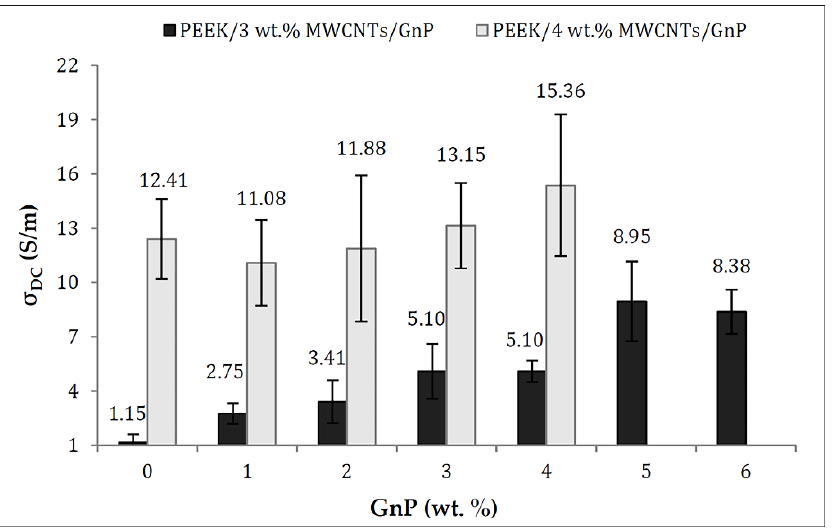
Figure 5. Direct Current (DC) volume electrical conductivity of PEEK/MWCNT/GnP nanocomposites as a function of GnP (1 to 6 wt%) content (at CNT contents of 3 and 4 wt %) [22]. Reproduced under lished in 2009.